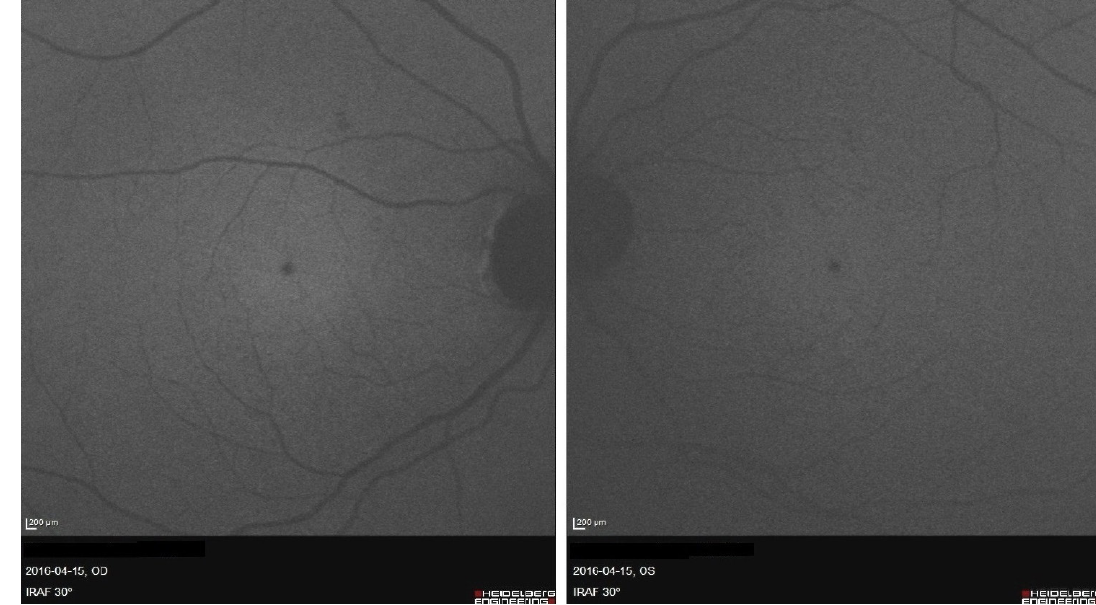
Figure 4: Near-infrared fundus autofluorescence images (NIA) of both eyes: clearly visible hypoautofluorescent spots in the